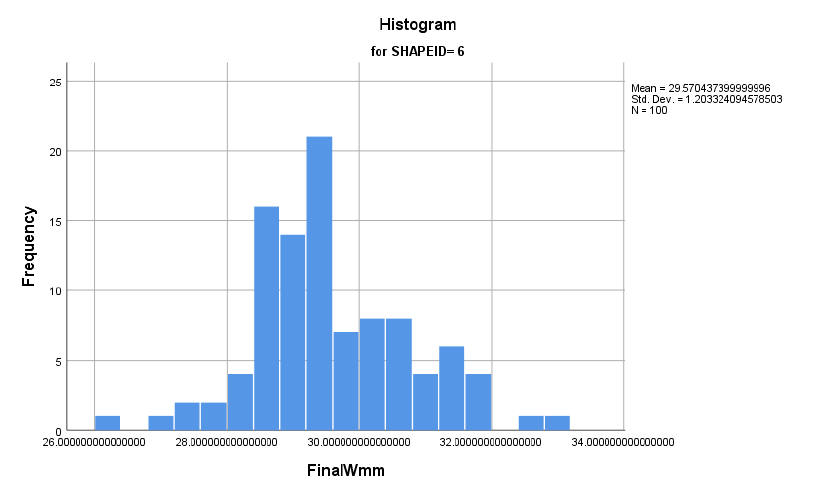
Figure A13. Shrink width adjustment for 30 mm.